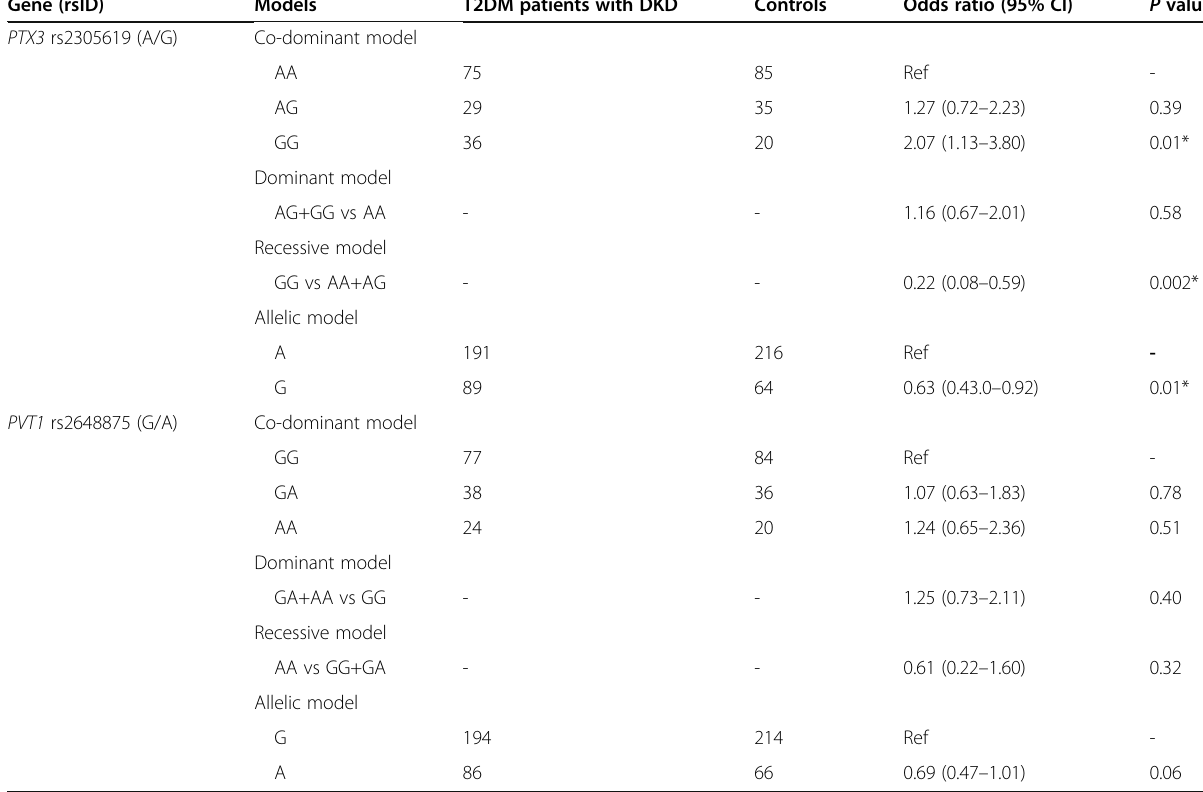
Table 4 Association of PTX3 and PVT1 gene polymorphism in T2DM patients with DKD and controls Gene